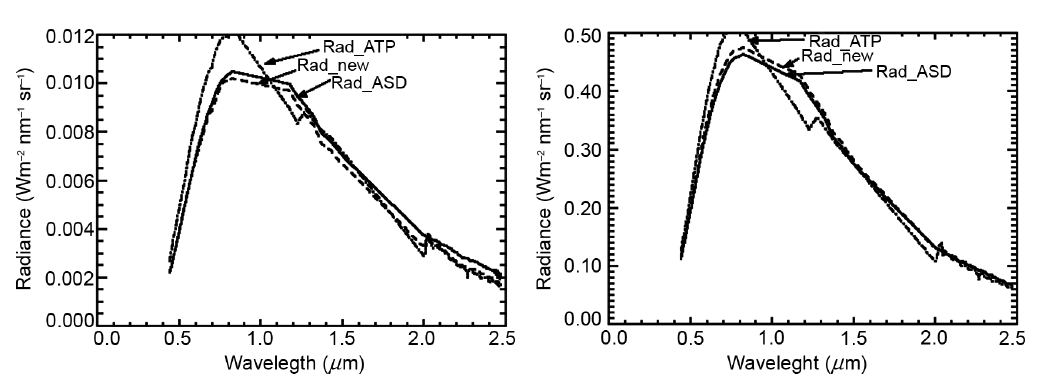
Fig. 4. Comparison of Spectralon radiance measured in the TB. Rad_ATP curve is the MIVIS radiance cali- brated with RF from ATP; Rad_new is the MIVIS radiance calibrated with the new procedure; Rad_ASD is the ASD measured inside the